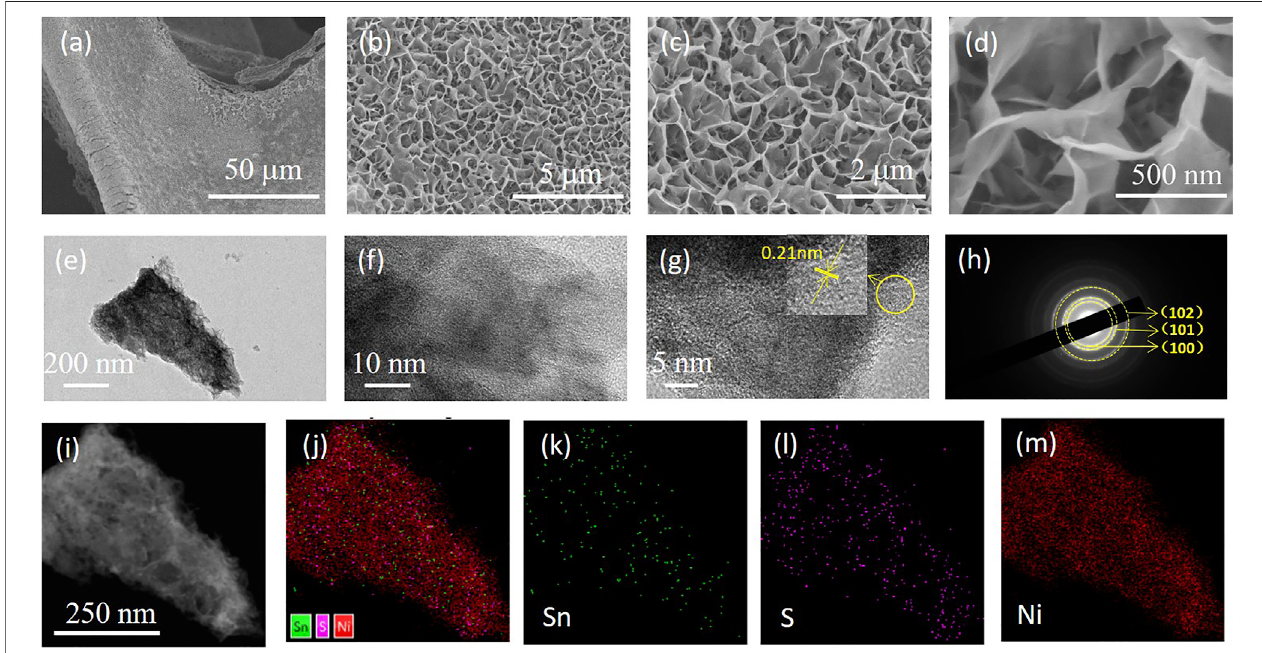
FIGURE2|(A – D) SEMimagesatdifferentmagni fi cationsoftheNi@SnS 2 nanosheetarrays; (E – G) TEMimagesatdifferentmagni fi cations; (H) SAEDpattern; (I – M) Elemental mappings.